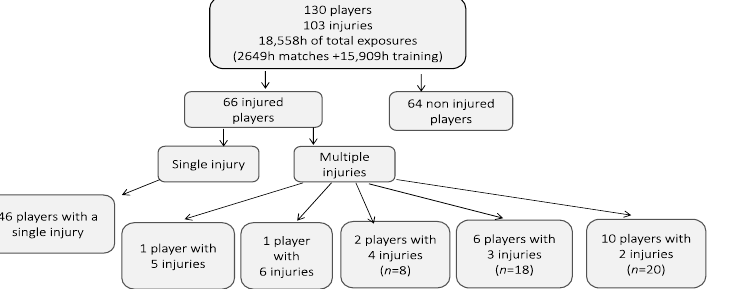
Figure 1. The flow diagram presents the number of players and injuries for one season.